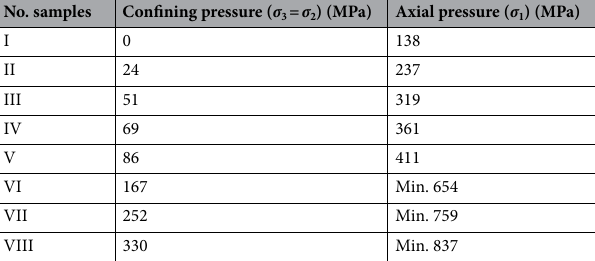
Table 1. The measured points of failure at the stress space for the marble (recalculated values) 24 .